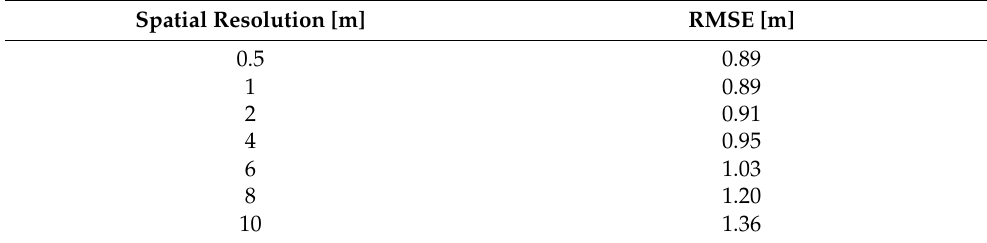
Figure 14. Performances of the DDMs obtained from different spatial resolutions of Pleiades-1A and calibrated with ICESat-2. Table 4. Accuracy using the original image resolution and lower spatial